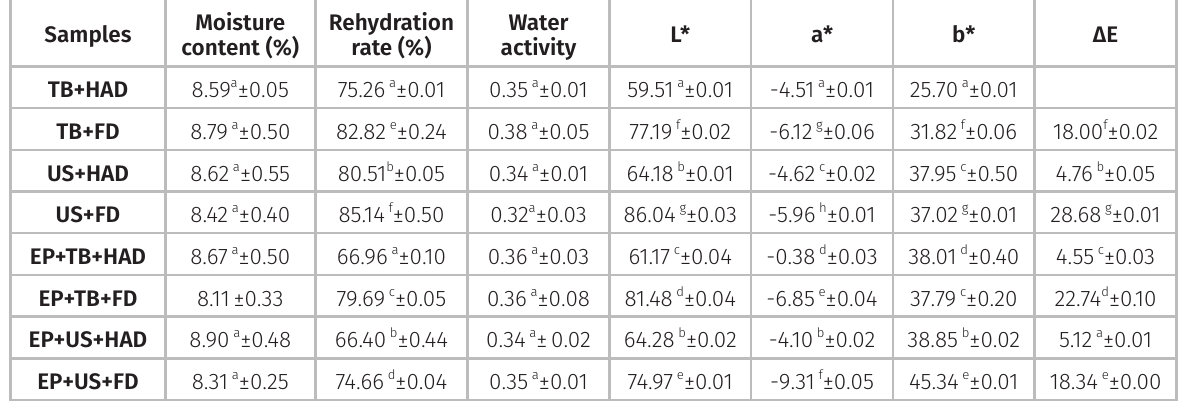
Table I. Some quality characteristics of zucchini chips